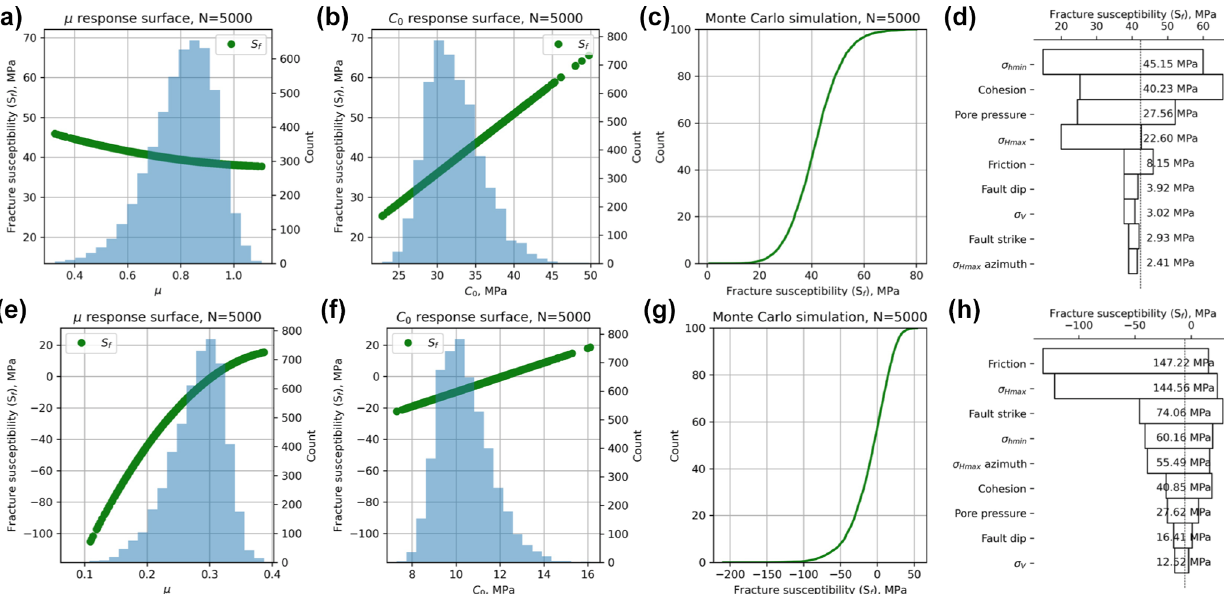
Figure 13. Outputs from the Monte Carlo simulation of fracture susceptibility ( S f ) in the Porthtowan Fault Zone. (a–d) The response surface for the base case, with friction and cohesion estimated from the laboratory failure tests of Zhao (1987), predicts positive fracture susceptibility, i.e. a stable fault zone. The tornado plot (d) shows that for relatively high values of cohesion (mode of C 0 = 30MPa in this case), the sensitivity to variations in friction is slight. (e–h) In contrast, the response surface for the “weak fault” case, with reduced values of friction and cohesion (mode of µ = 0 . 3, mode of C 0 = 10MPa), predicts fault zone instability, i.e. overwhelmingly negative values of S f . The effect of friction on these predictions is now very strong, as shown in the shape of the response surface for µ (e) and in the ranking within the tornado plot (h) .